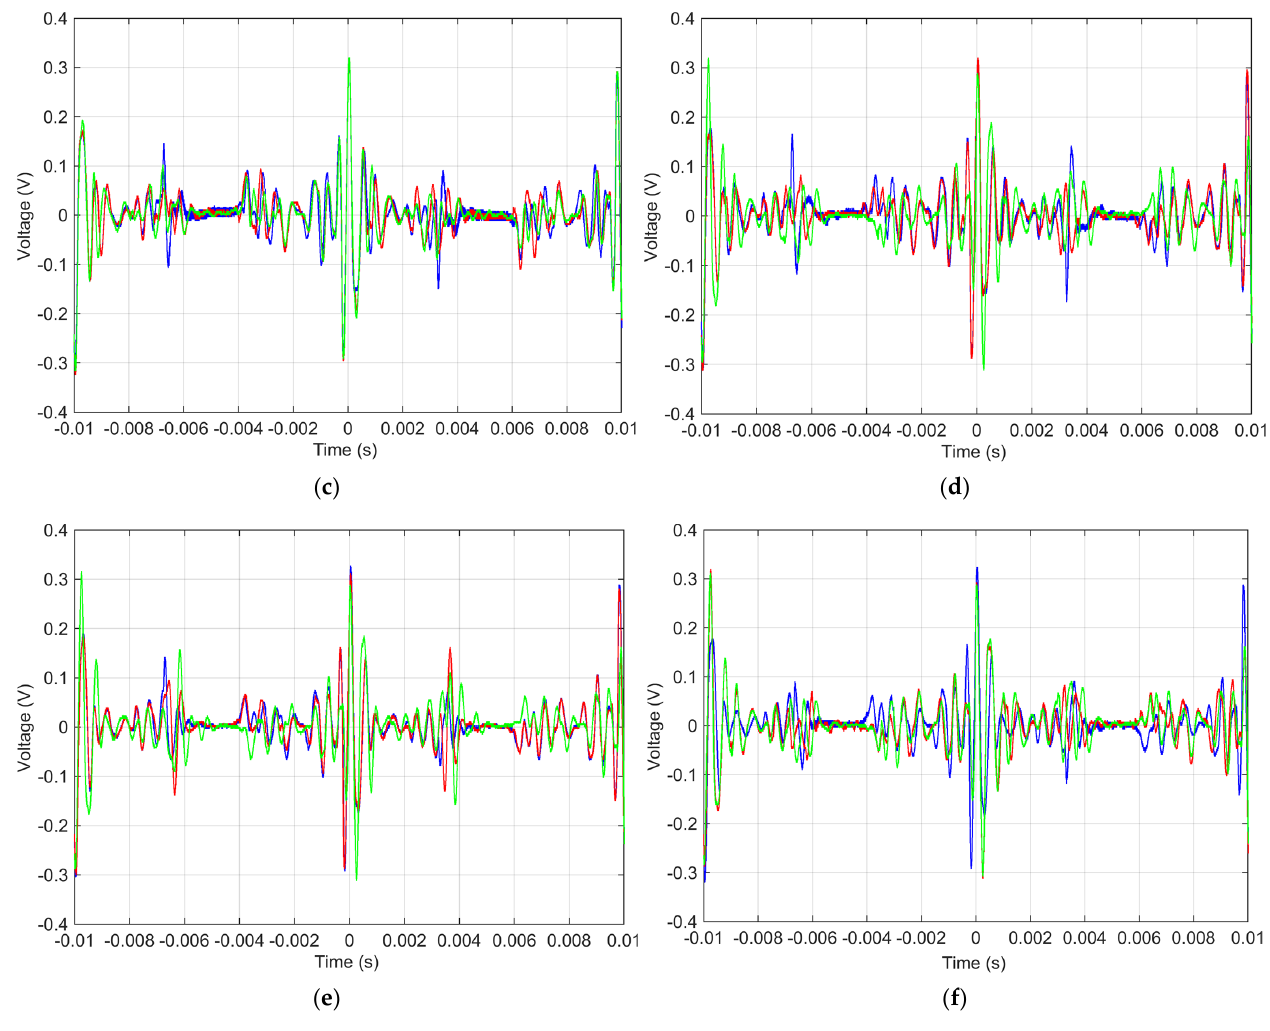
Figure 8. High-pass filtered time-domain waveforms for no load (green) and 25% (red) and 90% (blue) loads: ( a ) Lacie White, ( b ) Lacie Black, ( c ) KTEC, ( d ) Shenzhen, ( e ) Balance and ( f ) Kario.